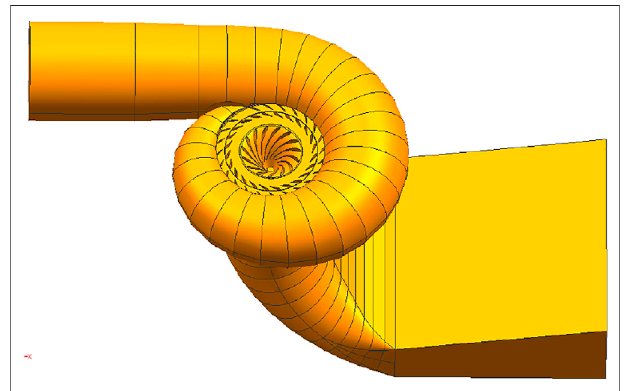
FIGURE 2 | The geometric model of the overall computational domain.